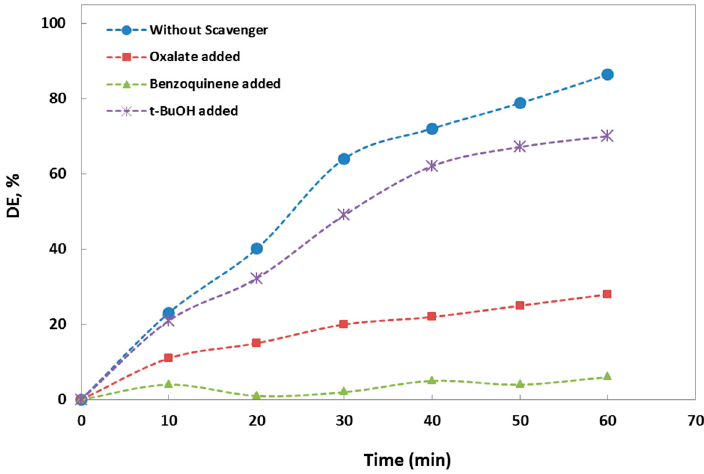
Figure 9. The effects of various scavengers on decolorizing Reactive Black 5, [Dye] = 20 mg/L, [Catalyst] = 1 g/L, [Scavenger] = 5 mM.